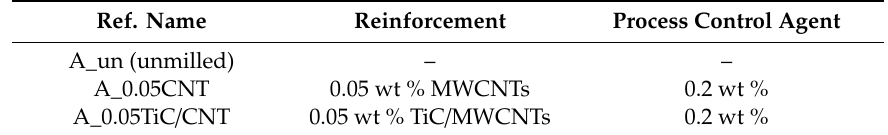
Investigated compositions. CNTs: carbon nanotubes; MWCNTs: multiwalled carbon